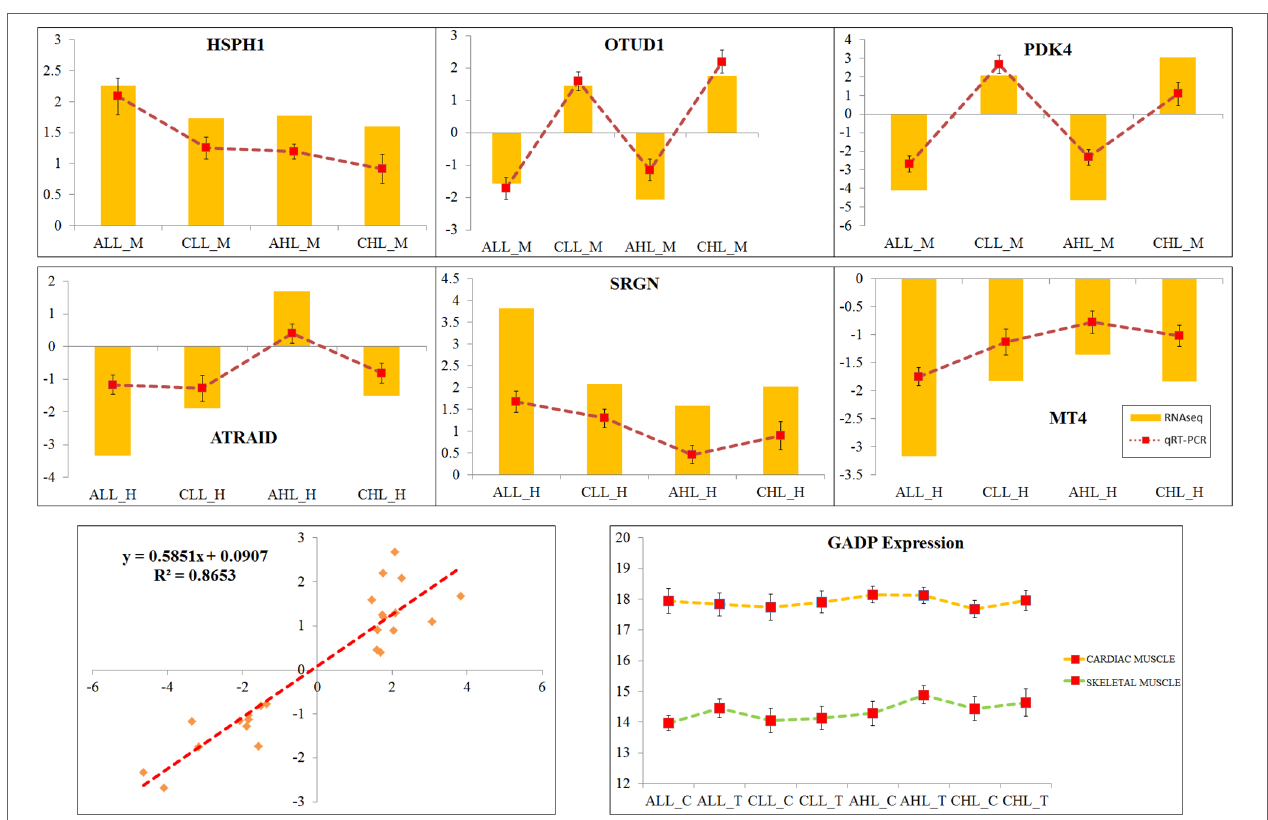
FIGURE 6 | Validation of RNA sequencing results with qRT-PCR analysis. The real-time PCR analyses of HSPH1, OTUD1, PDK4, ATRAID, SRGN, and MT4 were performed on all the samples that were used in the RNA-Seq analysis. GADPH, which showed constant expression in all samples, was used as a normalization gene. Log2 fold changes identified in the RNA-Seq analysis were plotted as bar, and the fold changes through qRT-PCR were plotted as line graph. A scatter plot of RNA-Seq Log2 fold change and the qRT-PCR fold change were plotted, and the correlation ( r 2 ) between the two methods was